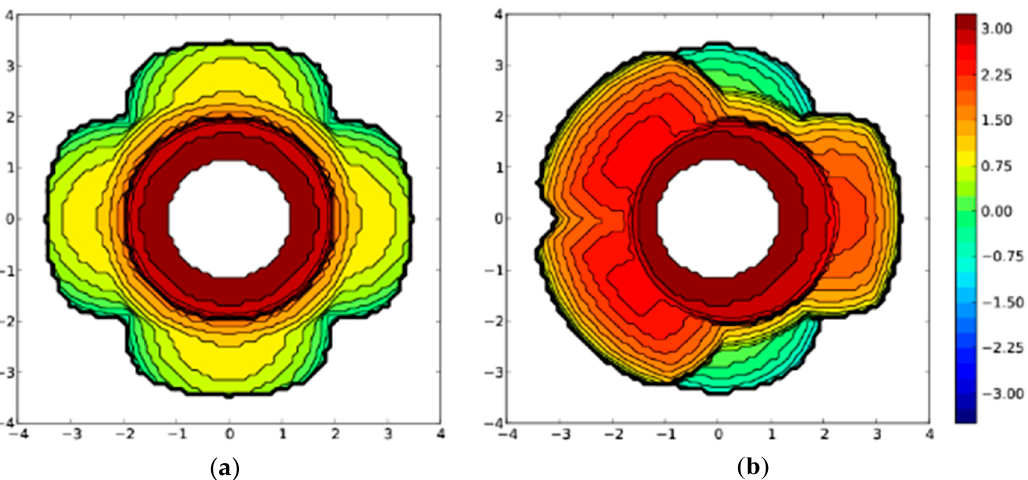
Figure 3. Topographic steric maps (xy plane) of the metal centres of ( a ) TaMe 5 and ( b ) WMe 6 . The corresponding metal is at the origin and one methyl of TaMe 5 is on the z axis. The isocontour curves of the steric maps are given in Ǻ .